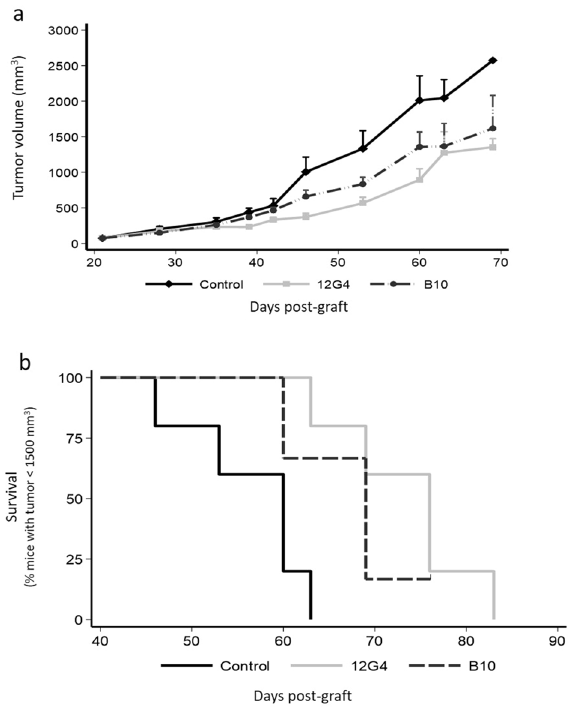
Figure 4. The anti-AMH antibody B10 reduces COV434-MISRII tumor growth in vivo . Nude mice bearing COV434-MISRII cell tumors were treated with B10 (anti-AMH antibody), 12G4 (anti-AMHRII antibody) (10 mg/kg/injection for both), or vehicle (NaCl; control) twice a week for 4 weeks. ( a ) Tumor growth curves (mean + 95% confidence intervals), and ( b ) Kaplan–Meier survival curves (percentage of mice with a tumor volume < 1500 mm 3 as a function of time after